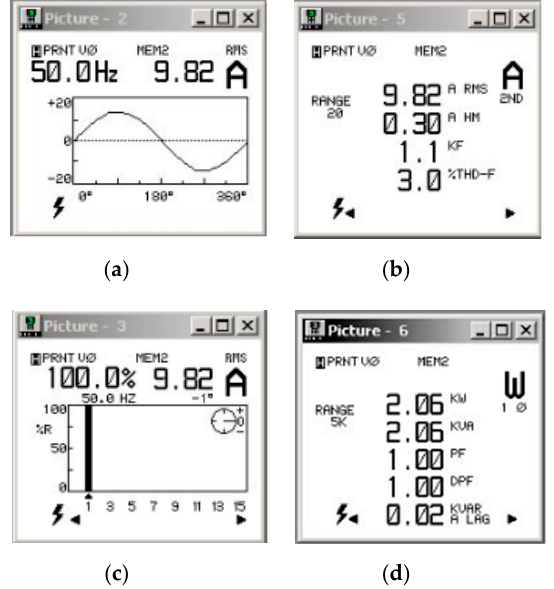
Figure 20. Experimental results for the adaptive control at nominal load on the supply side after compensation, in steady state regime, provided by Fluke 41B analyzer: ( a ) waveform of the supply current; ( b ) RMS value and supply current THD ; ( c ) harmonic spectrum of the supply current; ( d ) powers per phase and power factor.